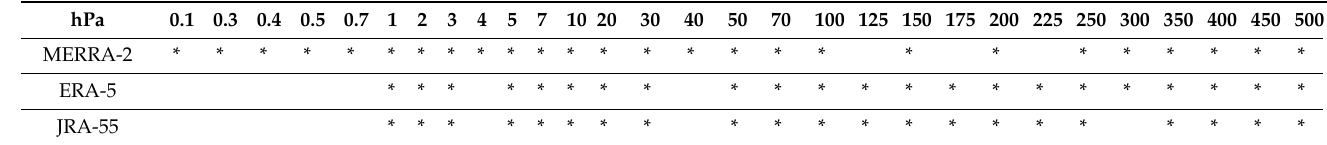
Table 1. Layers in reanalyses used in this